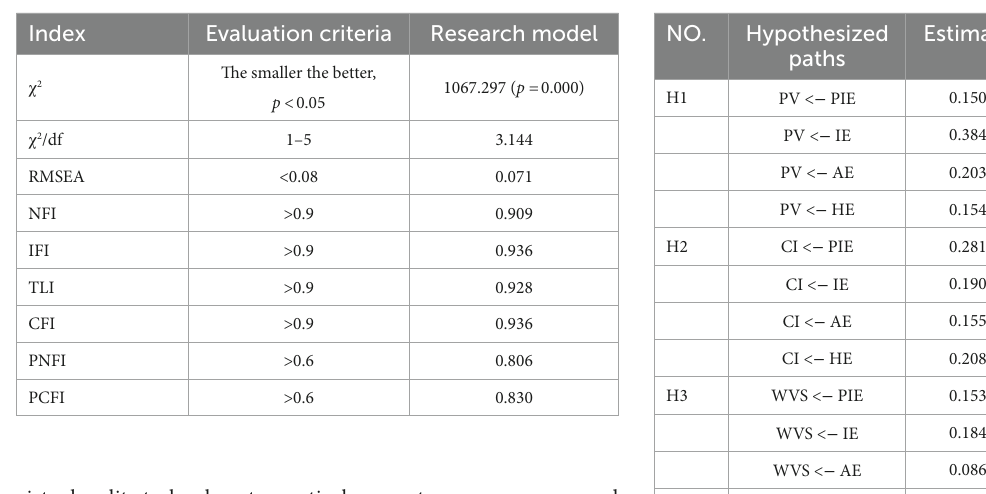
TABLE 4 Model fitness index values. TABLE 5 Path test